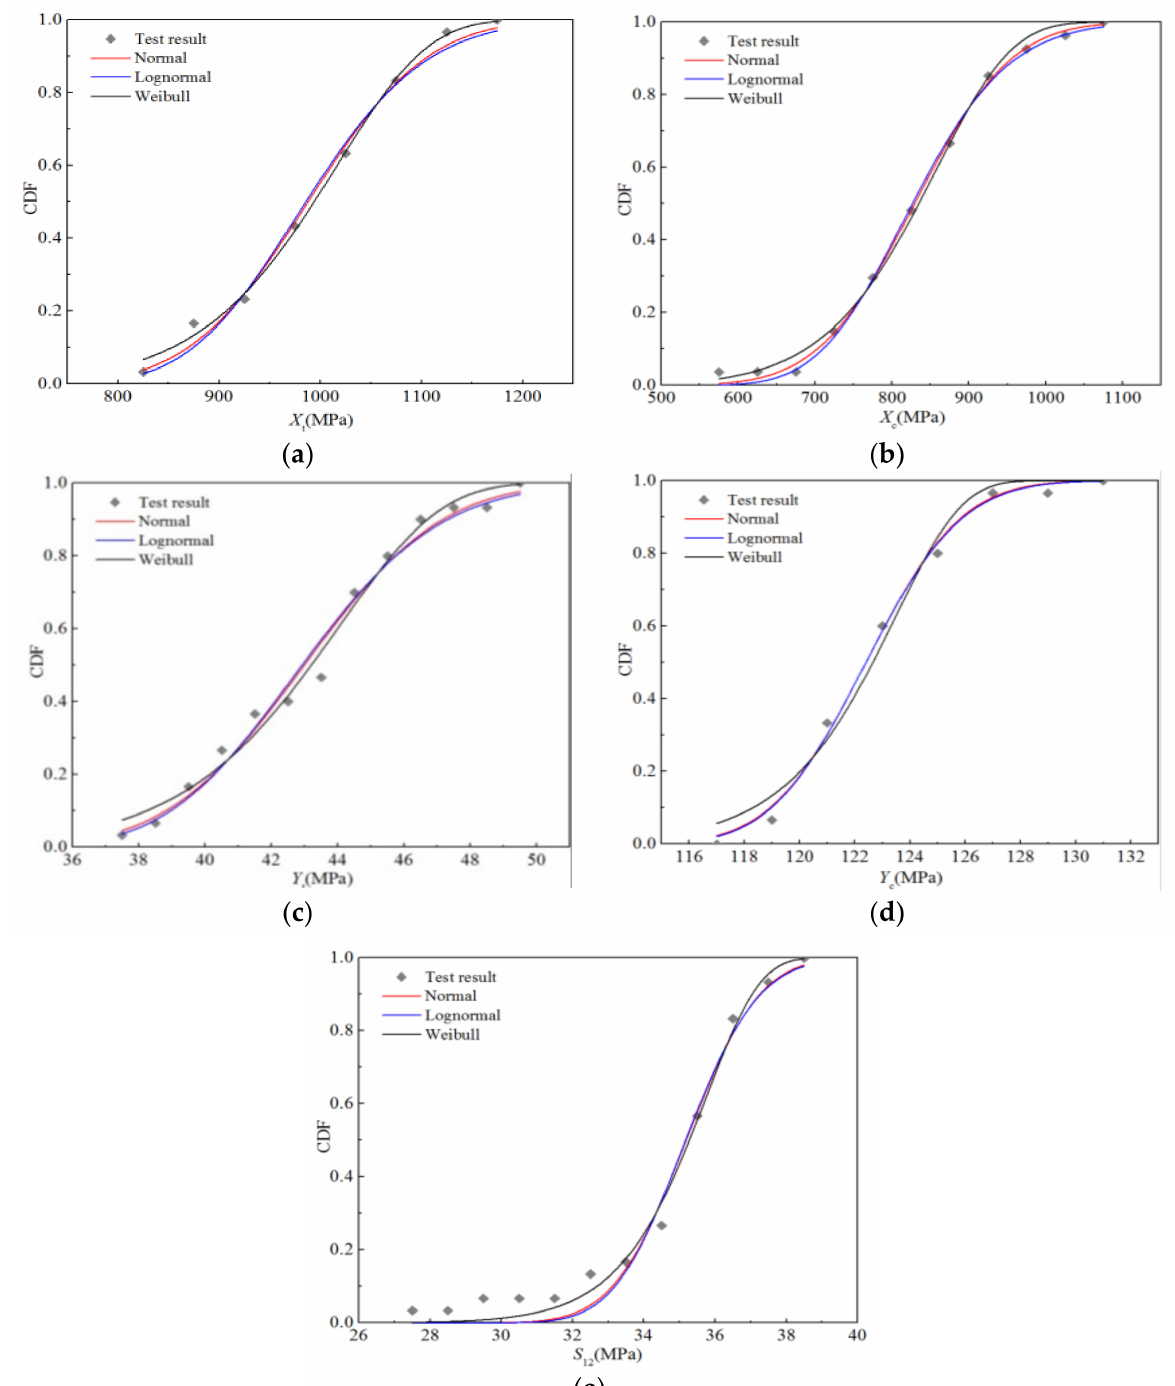
Figure 12. Functional fitting curves for the strength properties of H-GFRPs under the ETW